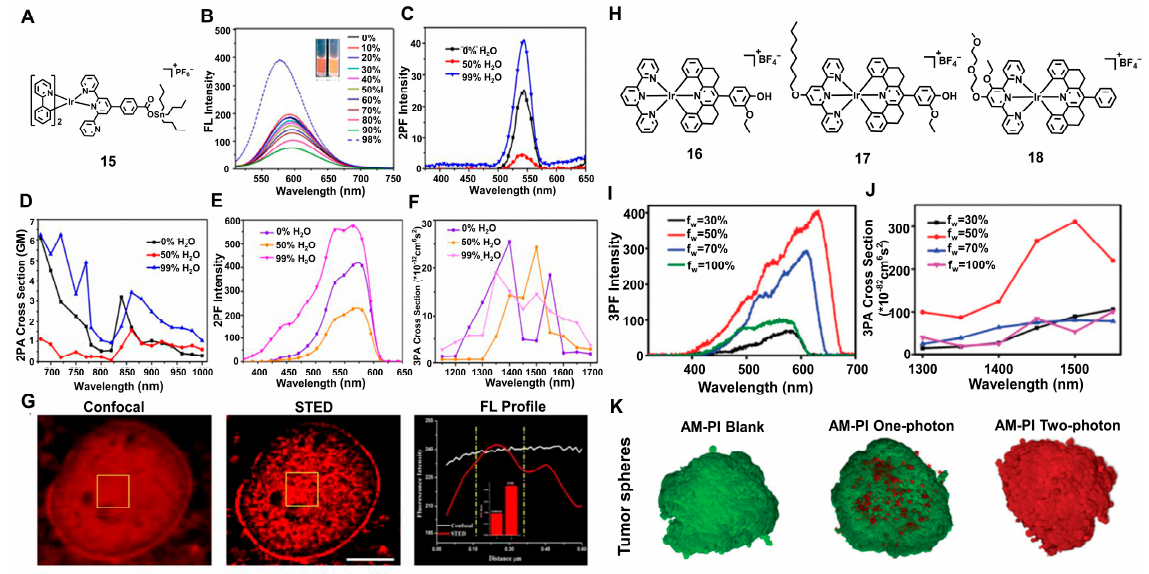
Figure 7. ( A ) The chemical structure of 15 . ( B ) PL spectra of 15 in different H 2 O fractions. ( C ) Two- photon fluorescence spectra of 15 . ( D ) Two-photon cross-section of 15 . ( E ) Three-photon fluorescence spectra of 15 . ( F ) Three-photon fluorescence spectra of 15 . ( G ) Two-photon fluorescence confocal imaging and stimulated emission depletion (STED) microscopy of 15 nuclear staining in A549 cells. Reprinted with permission from [64], copyright 2020, American Chemical Society. ( H ) The chemical structure of 16 , 17 and 18 . ( I ) Three-photon fluorescence spectra and ( J ) three-photon absorption cross-section of 16 . ( K ) 3D fluorescence images of 3D multicellular tumor spheroids under one-photon and two-photon laser irradiation. Reprinted with permission from [65], copyright 2022, Royal Society of Chemistry.